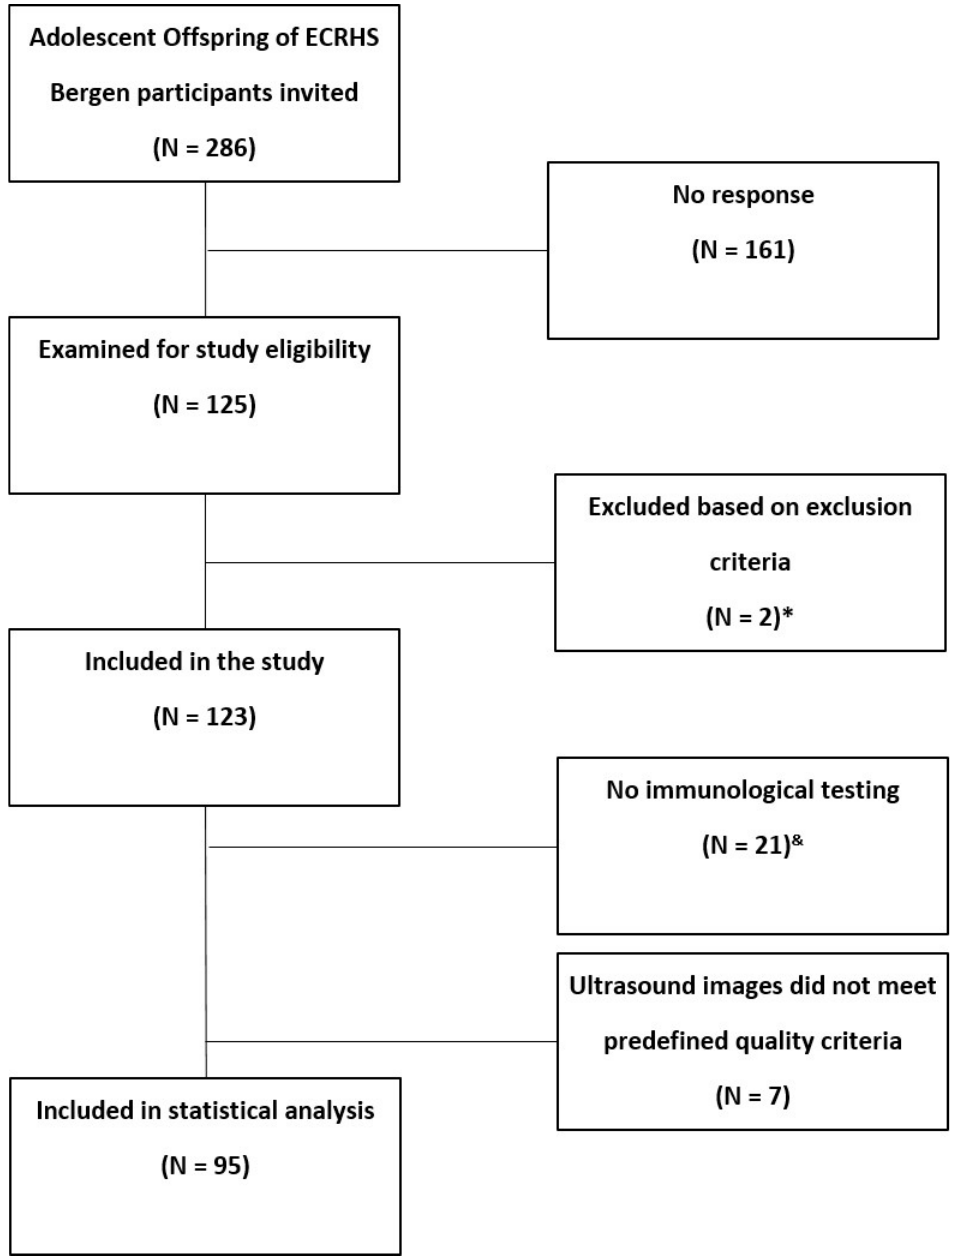
Fig 1. Participant recruitment process. � n = 2 with type 1 diabetes mellitus. Further predefined exclusion criteria were recent operation, an acute infection, diabetes mellitus type 2, any chronic inflammatory diseases unrelated to atopy, severe heart disease and pregnancy; & No participant´s consent for blood